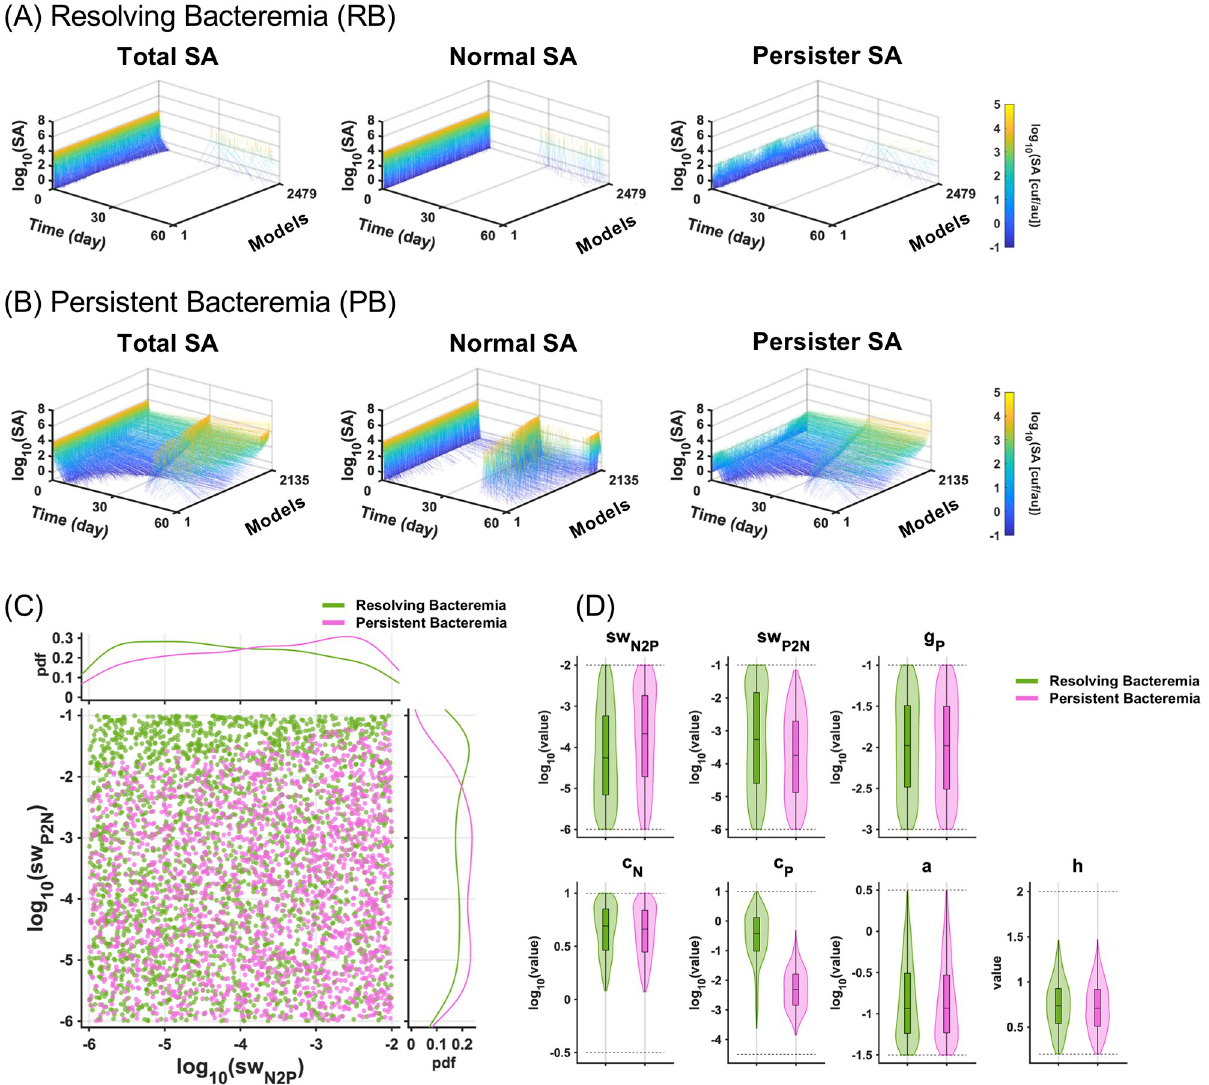
Fig 4. Comparison of models between resolving and persistent bacteremia. (A, B) Line plots of the number of total, normal, and persister SA over time (0–60 days) for resolving (RB) and persistent bacteremia (PB). The detection limit of bacteremia was set as 0.1 cfu/a.u. and 2,479 and 2,135 models were classified into RB and PB, respectively. In RB, 52 of models showed relapsing bacteremia and they were also included in the analysis. (C) Two- dimensional scatter plot of switching rates. (D) Violin plots and box plots of the parameter distributions of RB and PB. Dotted lines indicate the range of randomized parameter